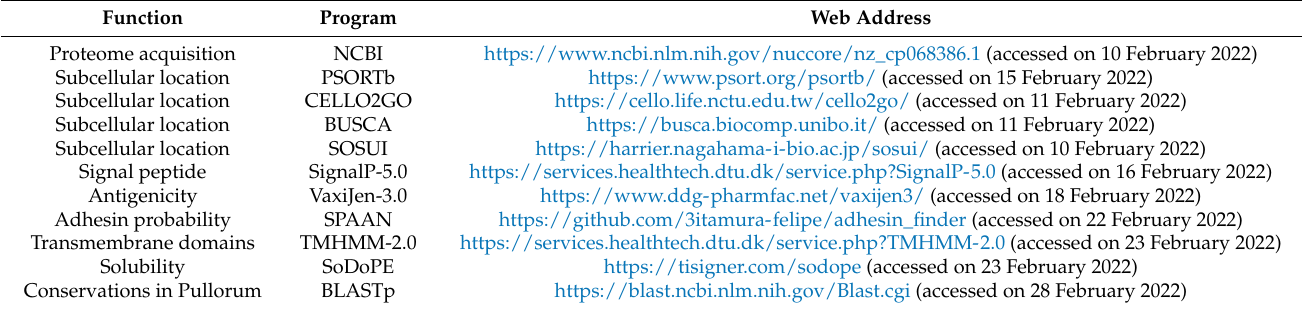
Table 1. A list of programs and web servers used in the present